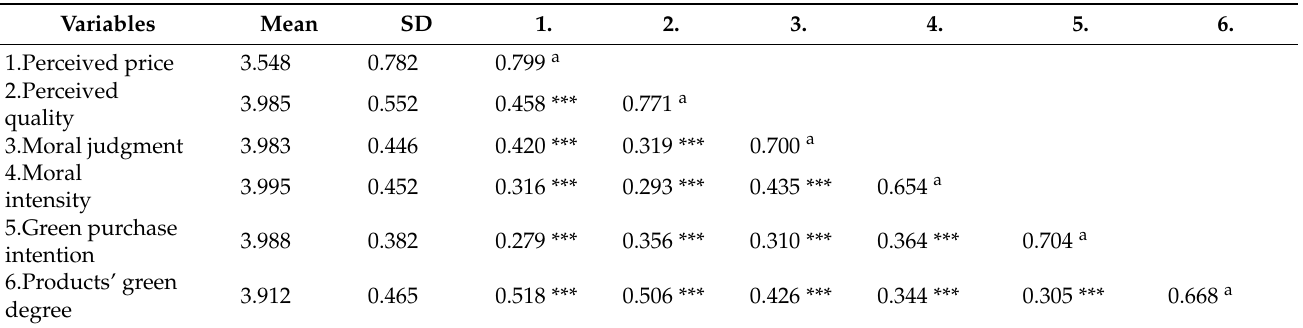
Table 2. Correlation analysis and discriminant validity.